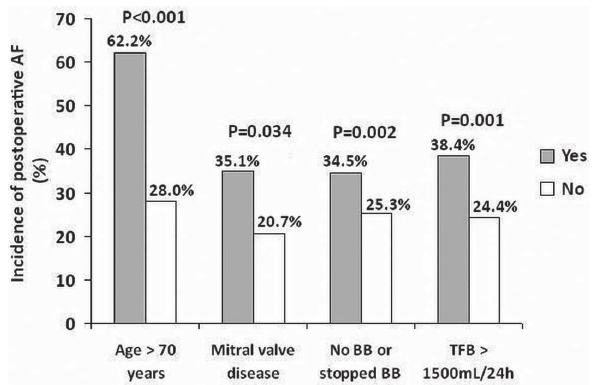
Fig. 2 - Relationship between the risk group classification according to the score and incidence of postoperative atrial fibrillation. AF: